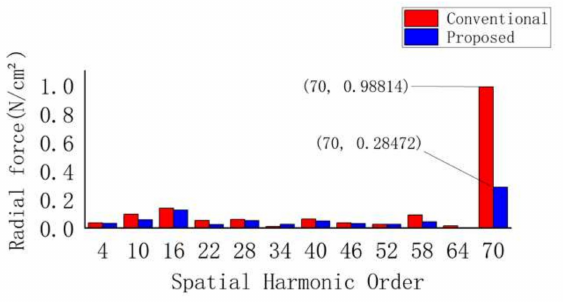
Figure 14. Electromagnetic force at 10f e frequency of a conventional and the proposed